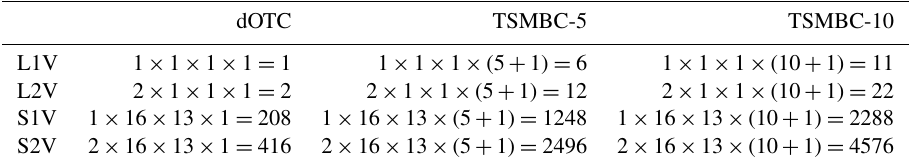
Table 1. Summary of the dimensions of the bias correction for each method used in Sect. 4. For each cell, the first value corresponds to the dependence or not between temperature and precipitation. The second and third are the dimension of the grid of the RCM (16 × 13 grid cells). The last values is the dimension to be corrected until the lag 0 for the first column, the lag 5 for the second column and the lag 10 for the last